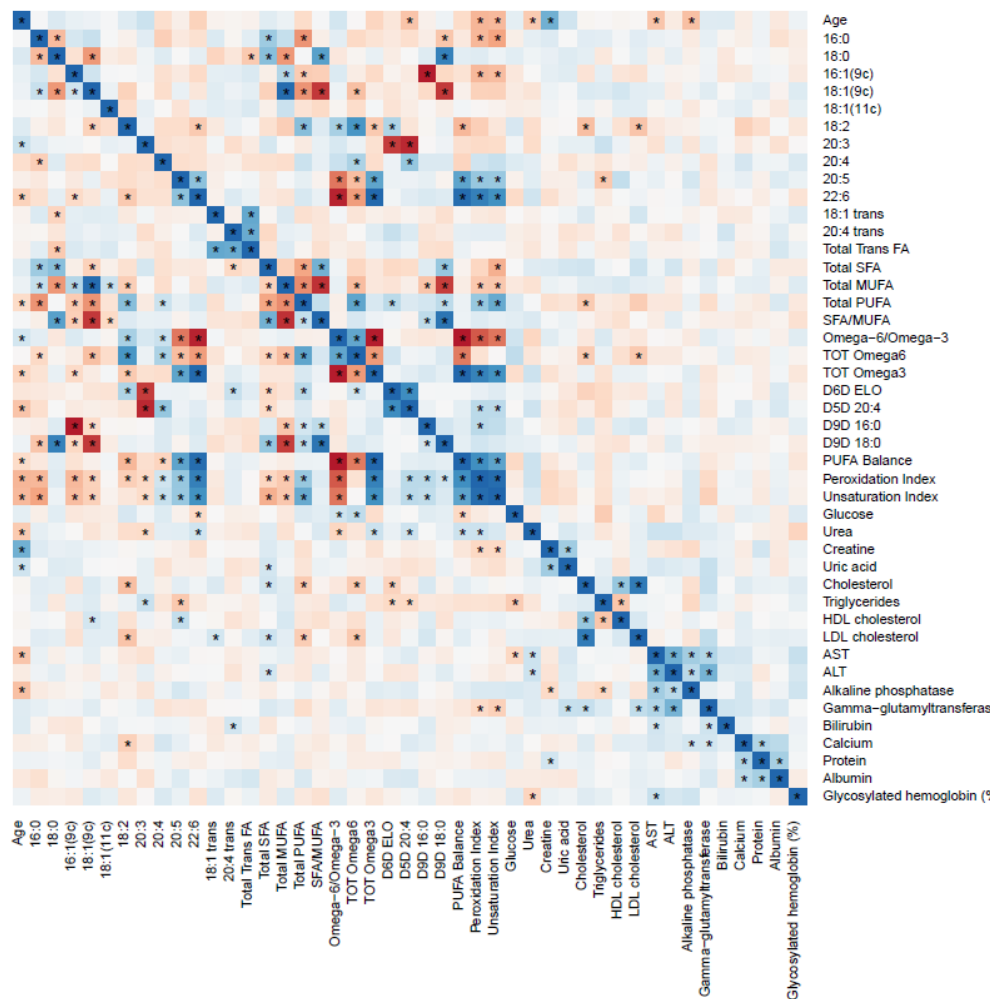
Figure 1. Heat map of the correlations between red blood cell membrane fatty acids and biochemical parameters for children with obesity. The color represents the Spearman correlation coefficient ( ρ ) (blue = positive; red = negative). * Represent significant correlations ( p < 0.05) between variables. The pair variables that have an * above and below the diagonal line are significantly correlated after correction for multiple comparisons ( q < 0.05).